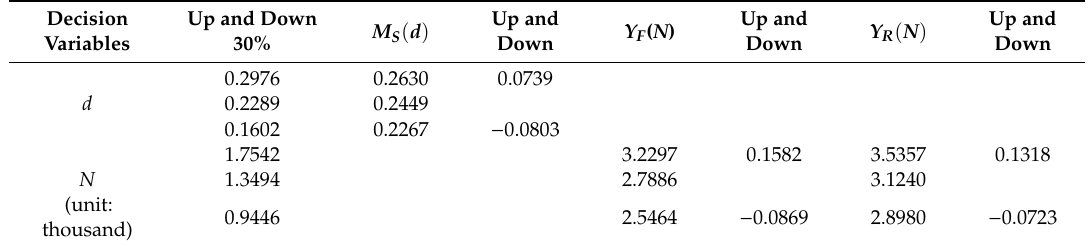
Table 2. Results of sensitivity analysis with decision variables in the London